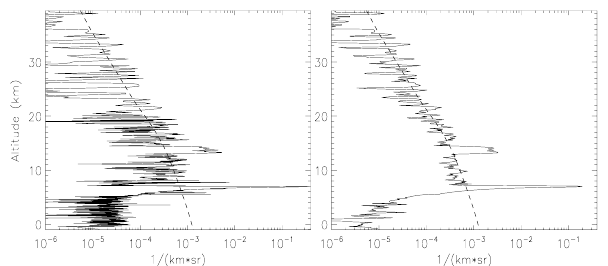
Fig. 1. CALIPSO raw calibrated level-1 532nm attenuated backscatter profile (left) and the corresponding database profile af- ter averaging the raw data to 3.5km horizontal and 125m vertical resolution (right) for a tropical scene showing an optically thin cir- rus cloud layer at 14km and an optically thick convective cloud between 6 and 8km. The dashed reference signal corresponds to a synthetic particle-free